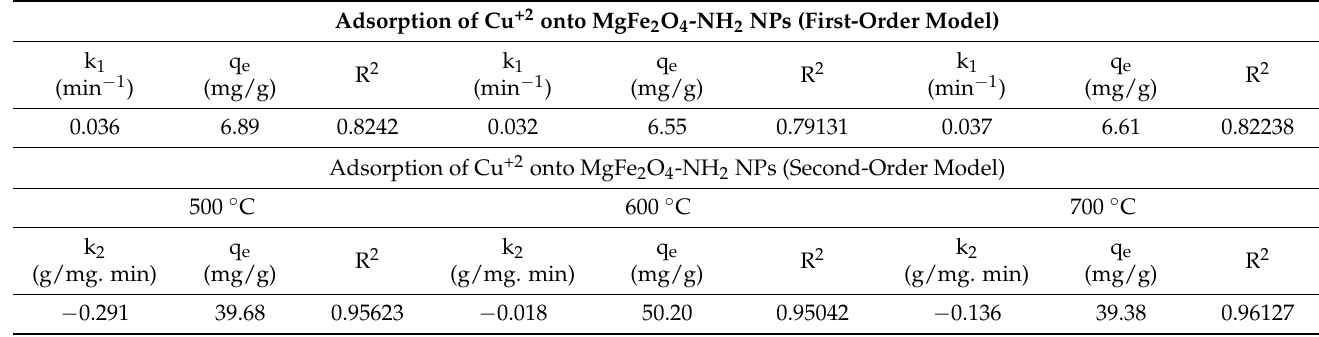
Figure 7. Pseudo-first-order adsorption plots of Cu +2 ions onto MgFe 2 O 4 -NH 2 nanoparticle pre-functionalization-calcined at ( a ) 500 °C, ( b ) 600 °C, and ( c ) 700 °C. Table 1. Pseudo-first- and second-order-based adsorption rate constant for Cu +2